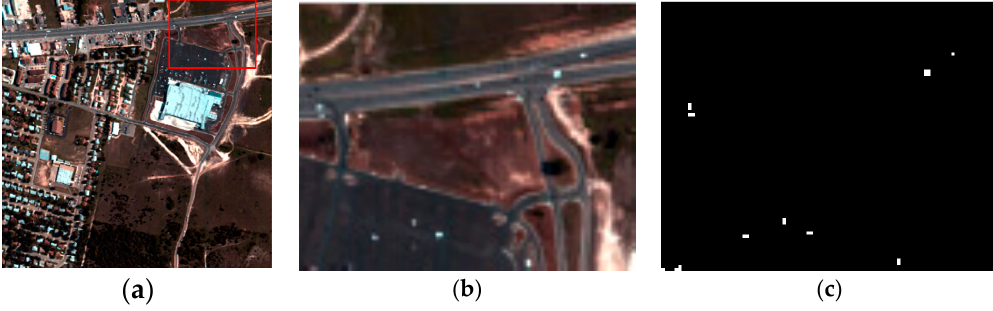
Figure 14. HYDICE data set: ( a ) RGB composite (55, 31, 22); ( b ) region of interest; and ( c ) ground-truth.